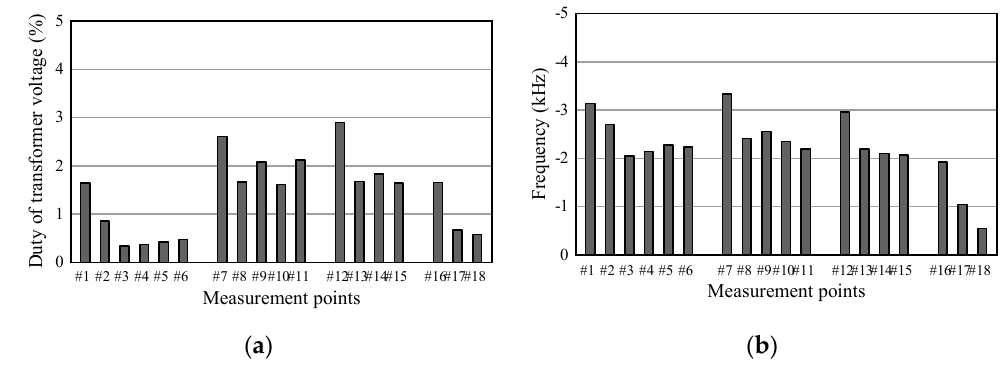
Figure 16. Results of subtract the simulation results from the experimental results for each measurement